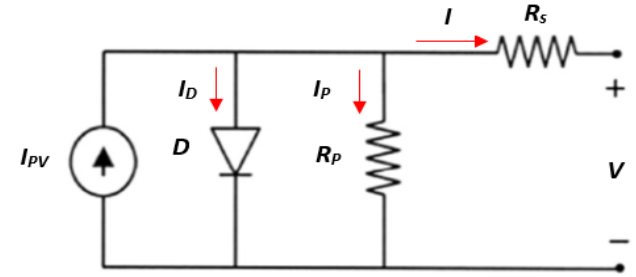
Figure 5. Equivalent circuit of the single diode model (SDM).